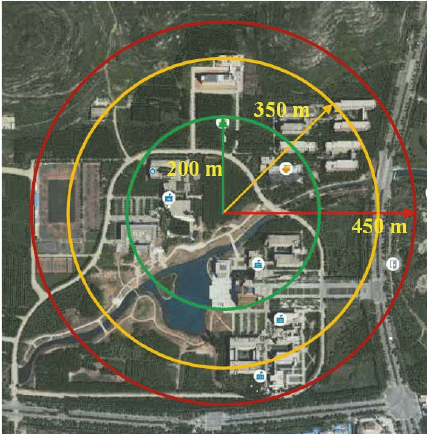
Figure 6: Simulation scenario. Table 1: Different sheltering factors in different areas. Type No.